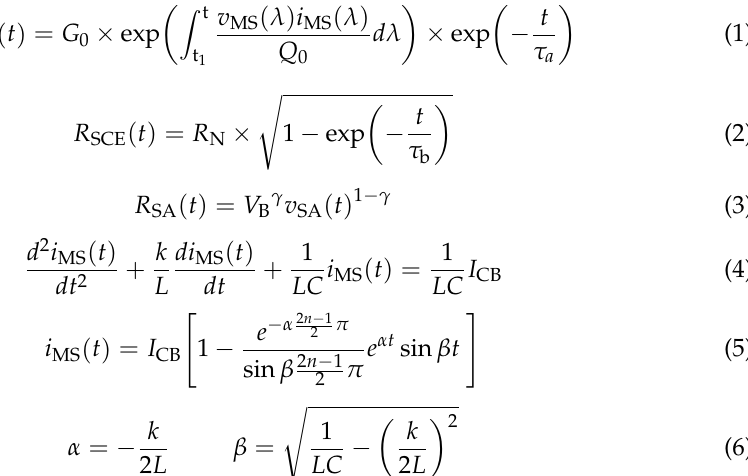
Ω Table 2. Design Parameters of Components Comprising Hybrid DCCB using Double Quench. Components